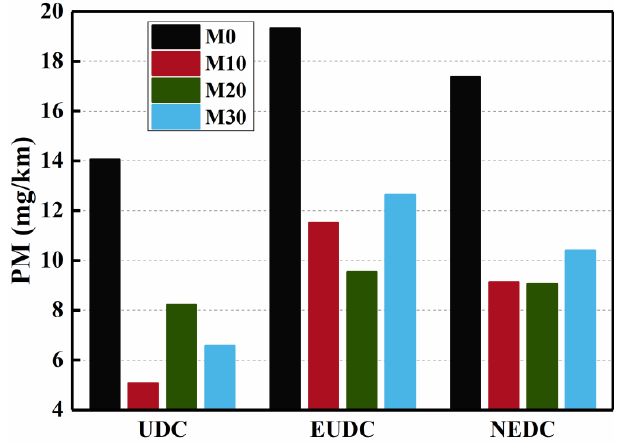
Figure 10. Effects of different methanol blending ratios on PM emissions under NEDC.